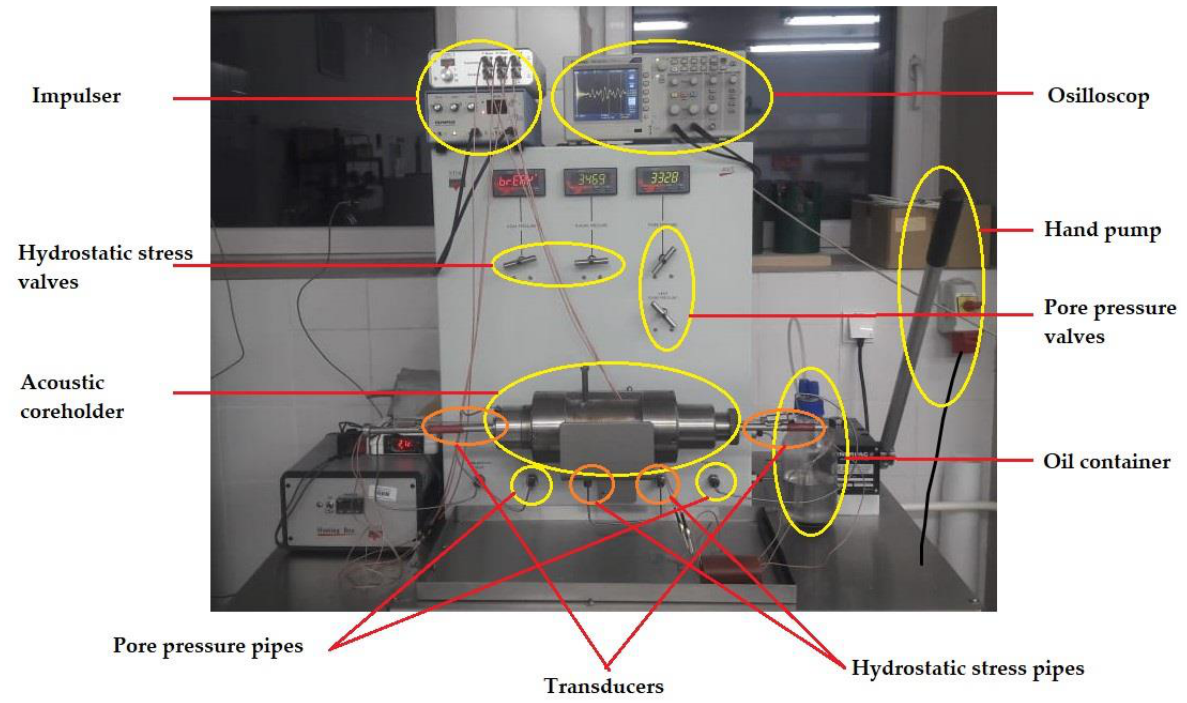
Figure 1. Acoustic velocity measurement (AVS) apparatus.